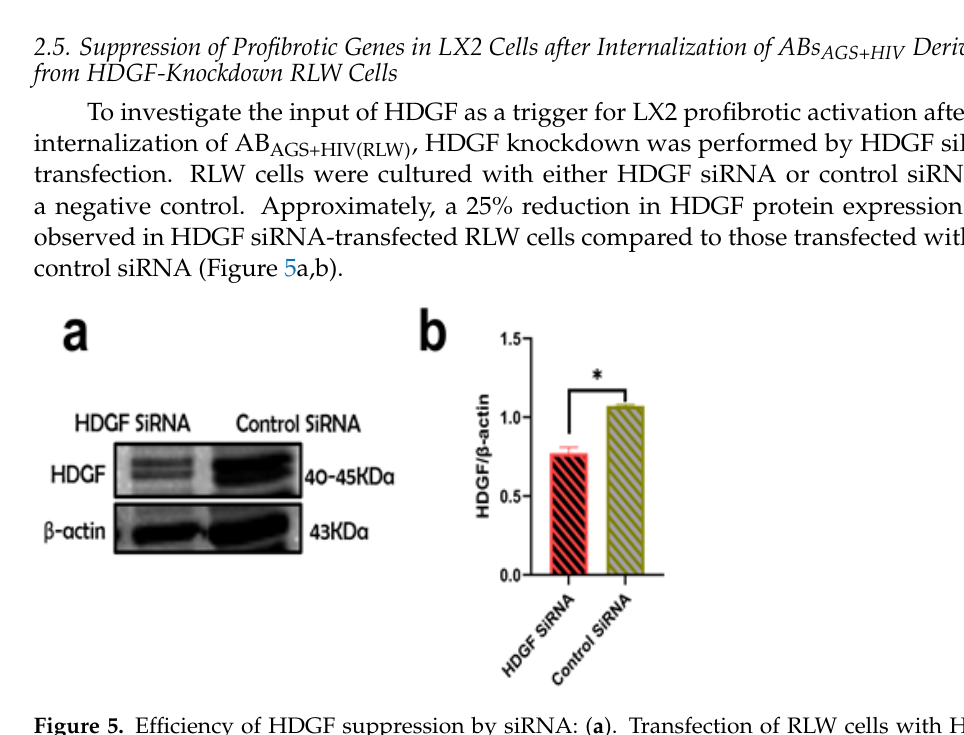
Figure 5. Efficiency of HDGF suppression by siRNA: ( a ). Transfection of RLW cells with HDGF siRNA. HDGF was measured in cell lysates of HDGF- or control-siRNA-transfected RLW cells by immunoblot analysis ( b ) Quantification of immunoreactive bands by NIH ImageJ. Data are from 3 independent experiments presented as mean ± SEM. Bars with * are significantly different from each other ( p ≤ 0.05).